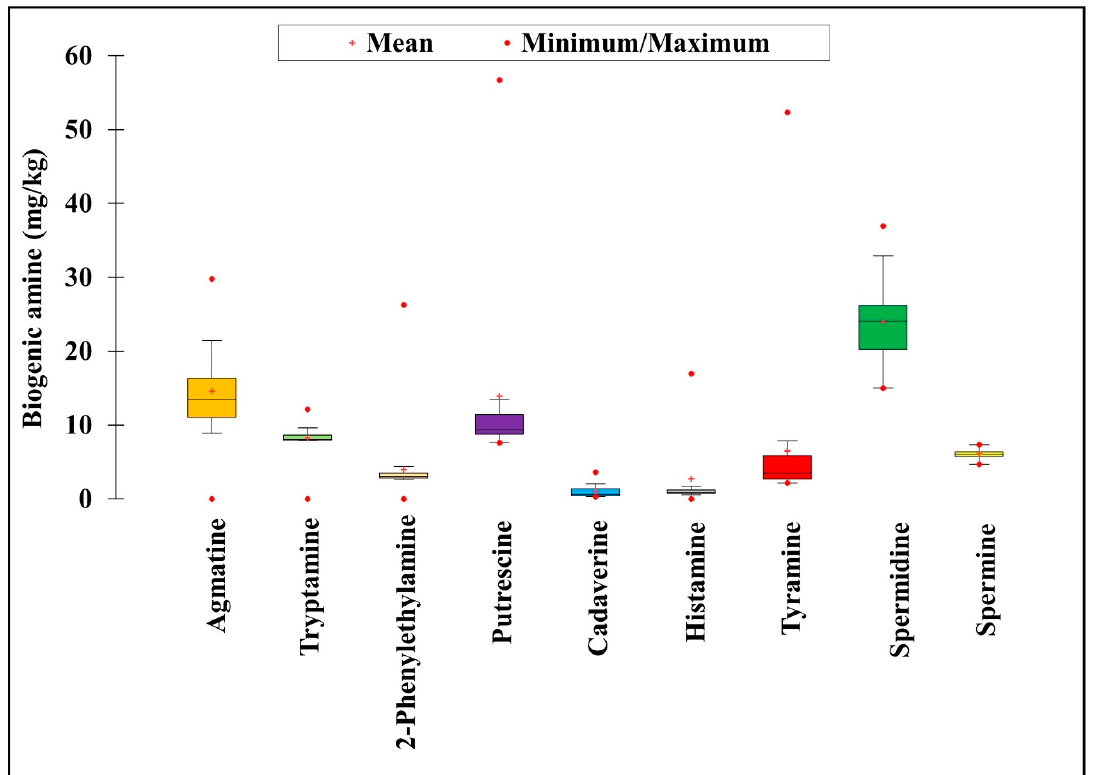
Figure 2. Mean quantity of various biogenic amines in the 35 traditional cottage industry gochujang products.